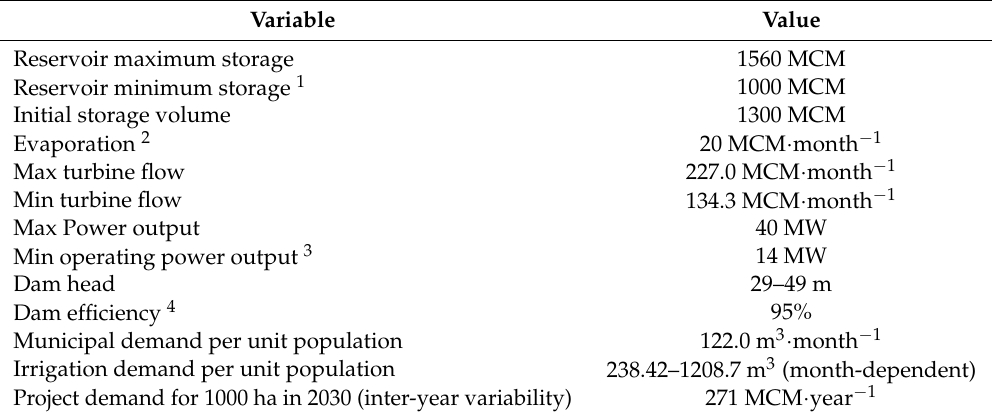
Table 1. Key model parameters and inputs (1: [32]; 2: [25]; 3: [34]; 4: